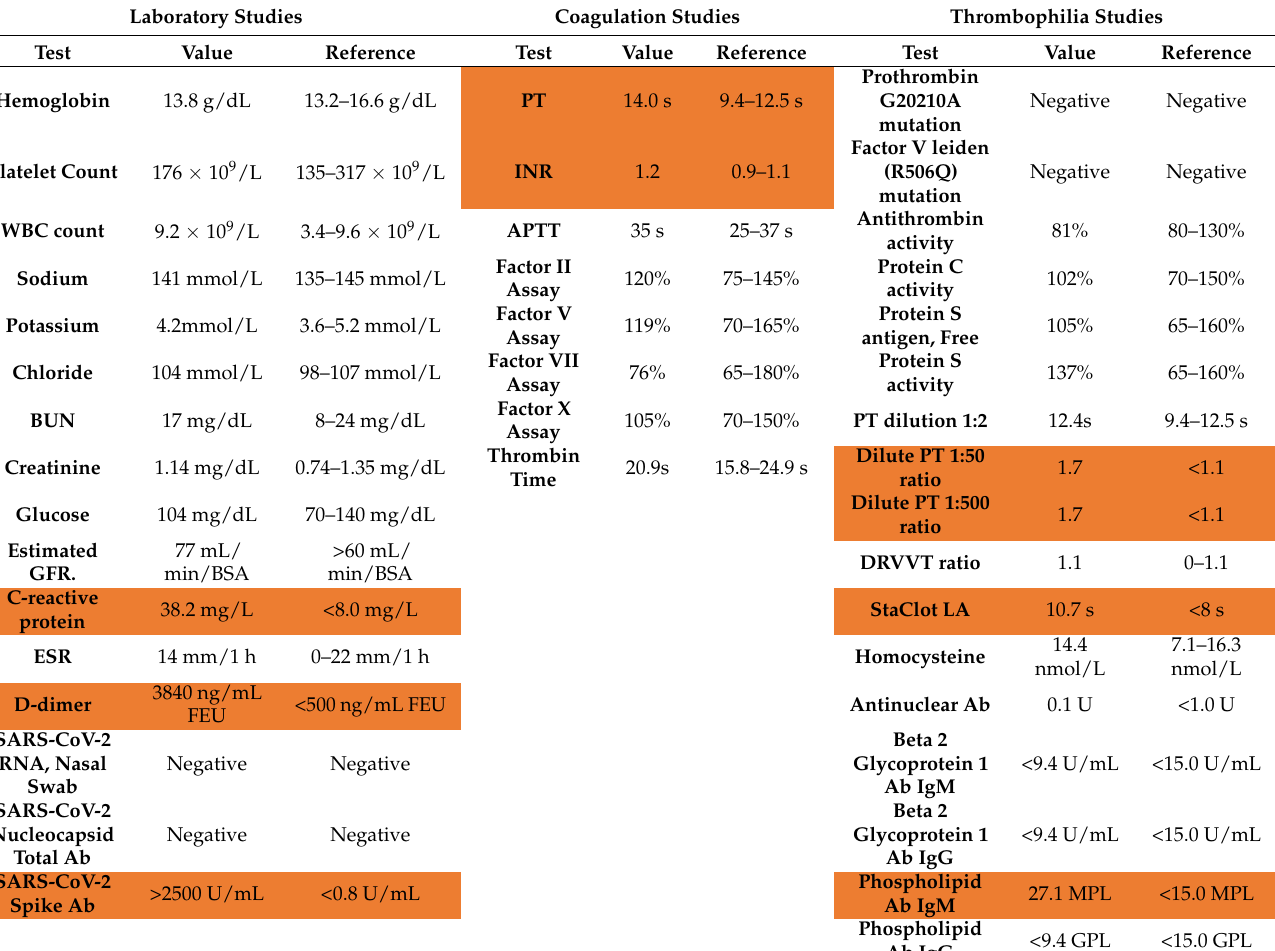
Table 1. Laboratory studies. Indicated tests with patient’s laboratory values, reference ranges, and units are provided. Abnormal values highlighted in orange. WBC = white blood cell. BUN = blood urea nitrogen. GFR = glomerular filtration rate. BSA = body surface area. ESR = eosinophil sedimentation rate. PT = prothrombin time. INR = international normalize ratio. APTT = activated partial thromboplastin time. DRVVT = dilute Russell viper venom time. MPL = IgM phospholipid units. GPL = IgG phospholipid units. Ab = antibody.